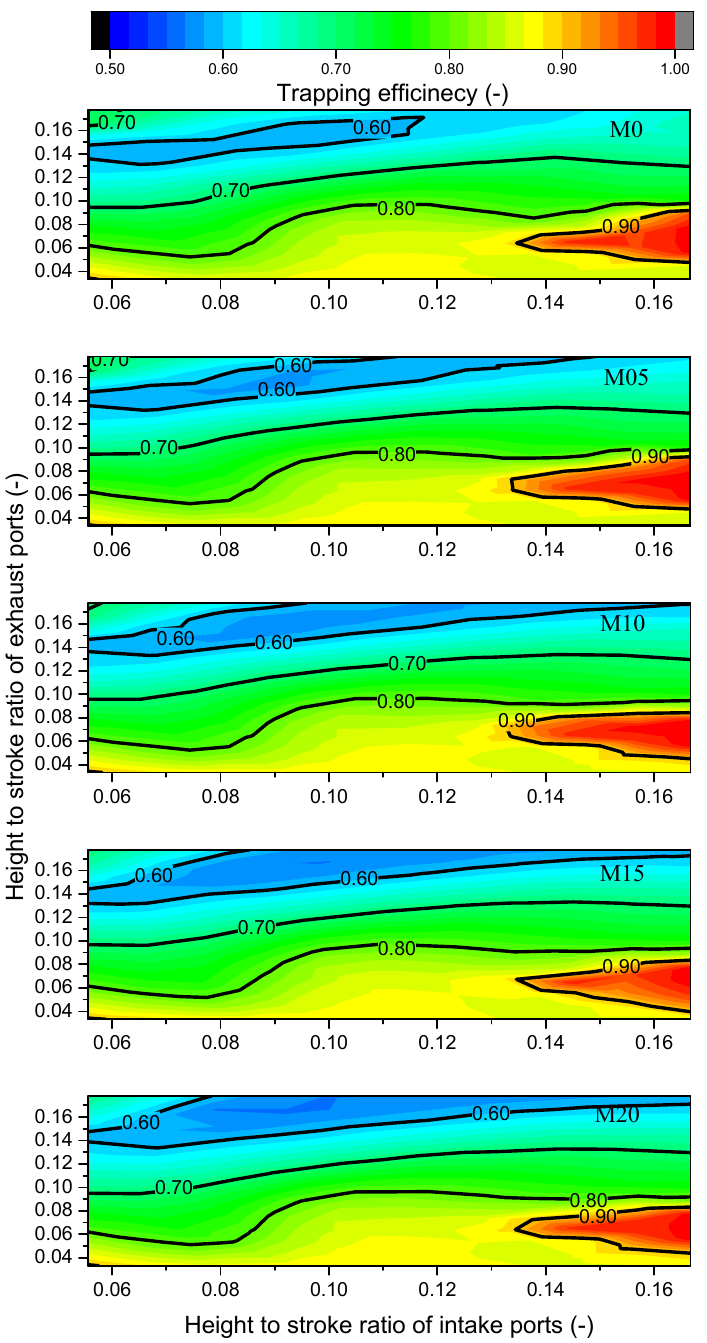
Figure 10. Trapping efficiency for the interaction of the intake and exhaust ports.